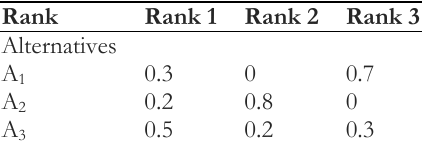
Table 9. Matrix γ.